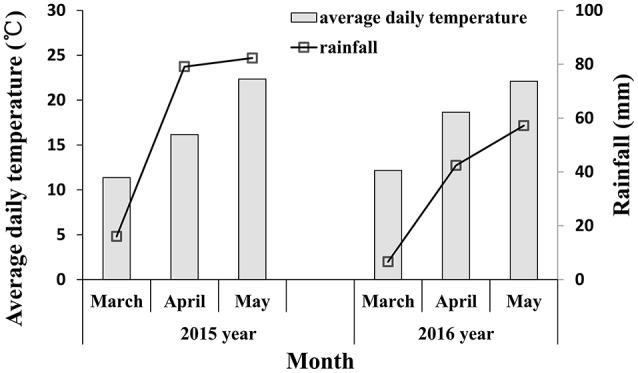
Meteorological data of March to May in 2015–2016 under our experimental area.